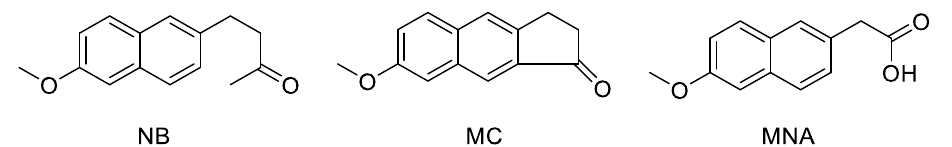
Figure 1. Chemical structure of the three studied compounds NB, MC, and MNA.